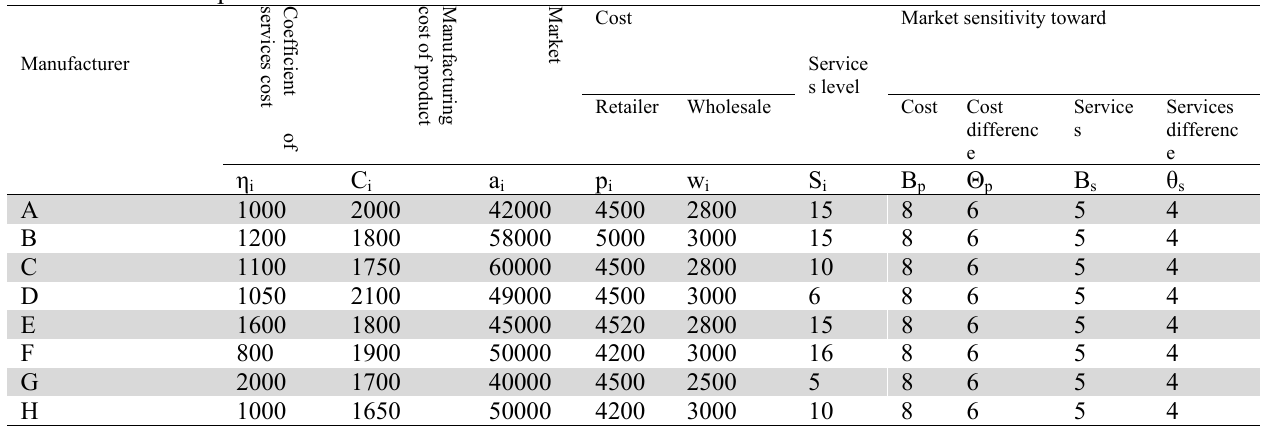
Data related to α piece